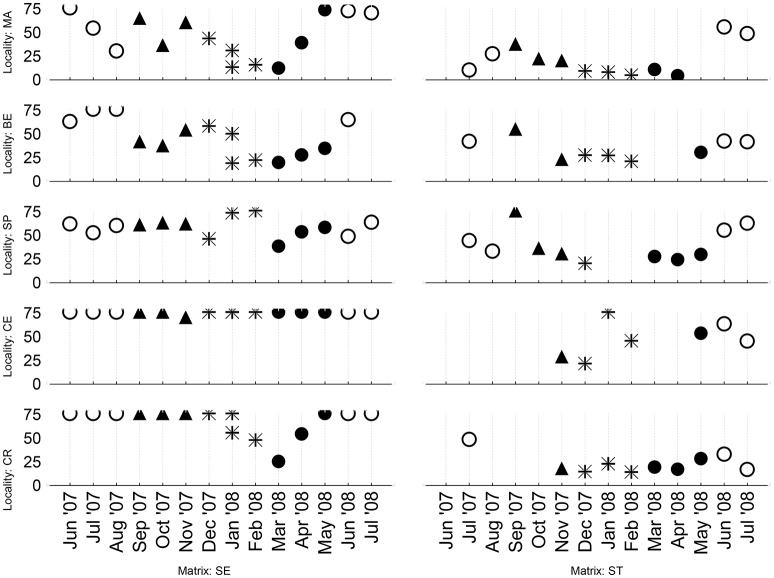
Seasonal toxicity in samples of bottom sediment (SE—left graphs) and samples from sediment traps (ST) at given sampling sites/localities (MA, Malenovice; BE, Belov; SP, Spytihnev; CE, Certak; CR, Certak oxbow lake). The toxicity (expressed as 50% inhibition concentration, IC50, in mg dry wt sediment/ml) is pictured vertically, whereas the horizontal axis shows the date of sampling (N.B. two samplings were carried out in January—on the 2nd and 30th). Used symbols correspond to clustering of samples into four seasons (● Spring, ◯ Summer, ▴ Autumn,  Winter).